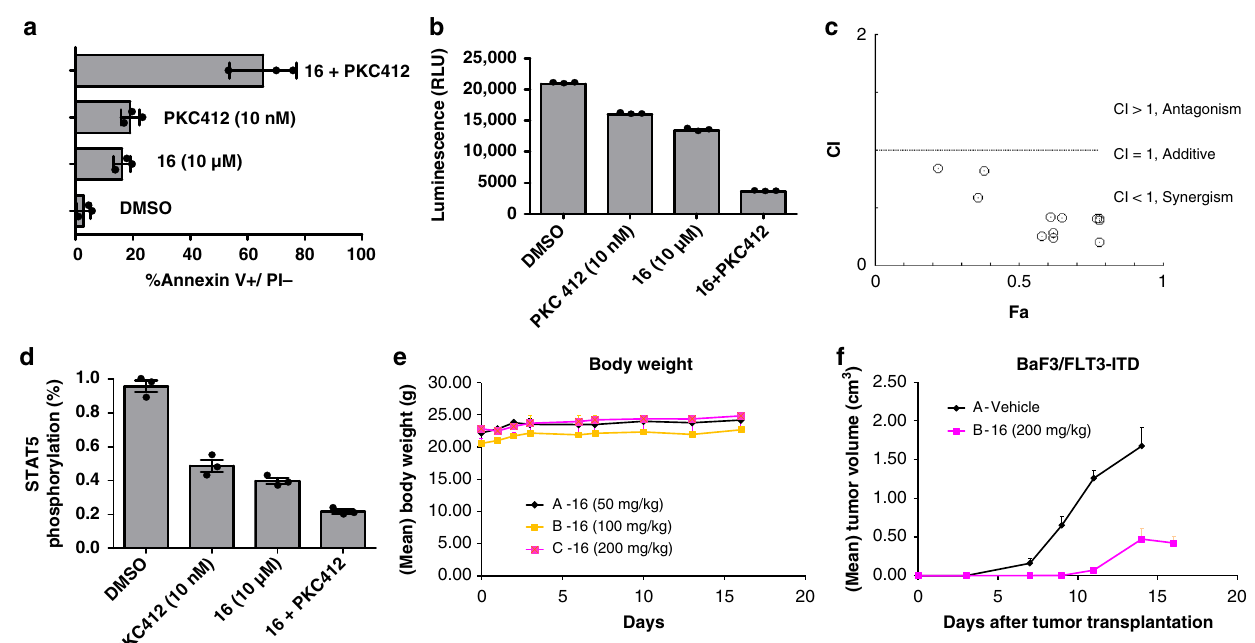
Fig. 6 Synergy of inhibitor 16 and kinase inhibitor midostaurin (PKC412). Activity tested in a murine cancer model. a MV-411 cells were treated with PKC412 (10 n M ) or compound 16 (10 µ M ) alone or in combination and incubated for 24 h followed by annexin-V/ propidium iodide staining and fl ow cytometry. Apoptosis was quantitated for three independent experiments ( n = 3) and error bars denote mean ± S.D. b Cell viability assays were carried out by treating MV-411 cells with compound 16 (10 µ M ) and PKC412 (10 n M ) alone or in combination. The number of viable cells was distinguished using an ATP-dependent bioluminescence assay (CellTiter-Glo, Promega) ( n = 3, error bars denote mean ± S.D.). c Combination index ( CI ) plot showing the synergistic effect of compound 16 and PKC412 in MV-411 cells. CI values were generated using CalcuSyn software (Conservion, Ferguson, MO) and plotted as a function of fractional growth inhibition ( n = 3) ( Fa ) where Fa = (A 570 control − A 570 treated)/A 570 control. CI values of < 1, = 1, and > 1 indicate synergism, additivity, and antagonism, respectively. Error bars denote mean ± S.D. d Relative STAT5 phosphorylation levels were plotted based on the raw data from western blotting chemiluminescence readings to study the synergistic effect of both compounds on STAT5 phosphorylation reduction. MV-411 cells were treated with compound 16 or PKC412 alone or in combination and incubated for 6 h ( n = 3, error bars denote mean ± S.D.). e The corresponding body weight changes in non-xenografted mice during compound 16 treatments ( n = 6, error bars denote mean ± S.D.). f Compound 16 signi fi cantly inhibits tumor growth in BaF3/FLT3-ITD xenograft tumor model. Time course of tumor growth suppressed by compound 16 (200 mg kg − 1 ) in mice bearing BaF3/ FLT3-ITD tumor ( n = 6, error bars denote mean ±